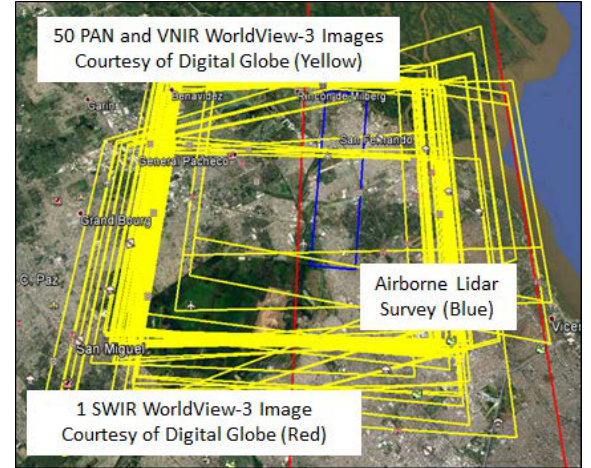
Figure 1 Polygons indicating benchmark data coverage are shown in Google Earth.